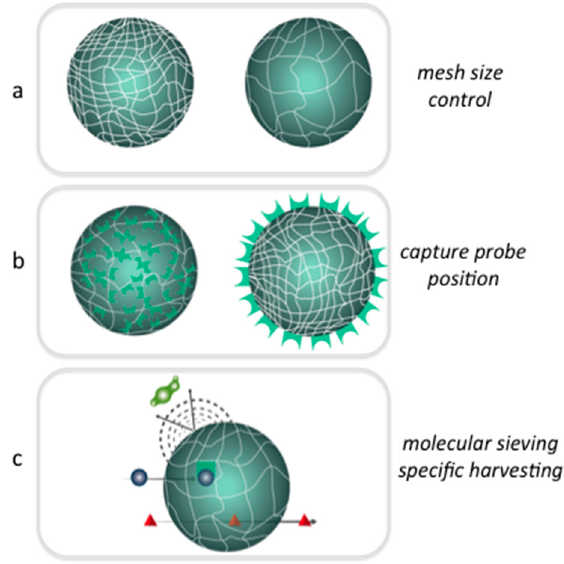
Figure 3. Hydrogels can be tuned in their physical and chemical properties to perform specific functions matching the need of the final applications: ( a ) tunable control of mesh size from polymerization reaction conditions; ( b ) versatile chemistry to allow the conjugation of capture molecule in different position; and ( c ) molecular sieving coupled to a specific capture of a given target obtained by changing the mesh size and cross-linking a ligand inside the hydrogel matrix.